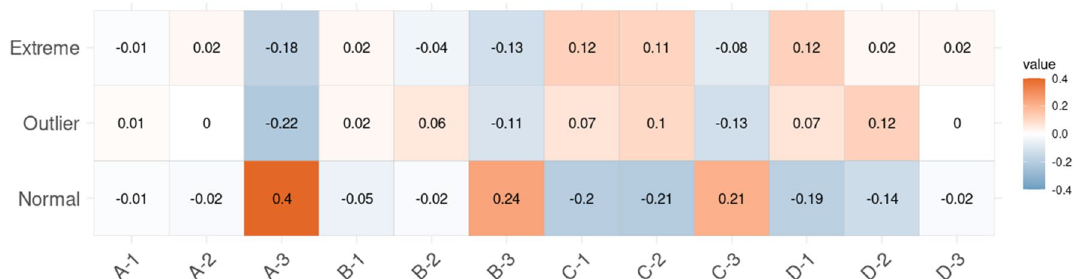
Figure 6. Results of the frequency analysis for categorized glycemia residuals. Residuals relative to G-statistic value for all combinations of income and educational attainment. Red color indicates that the frequency of individuals in the group is higher than expected if blood glucose residual levels were independent of income and educational groups, while blue denotes a lower frequency than expected under the assumption of